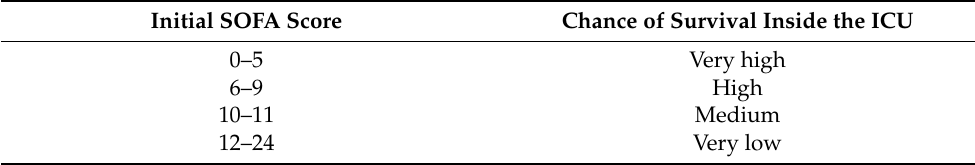
Table 2. Estimation of the patient’s chance of survival inside the ICU.